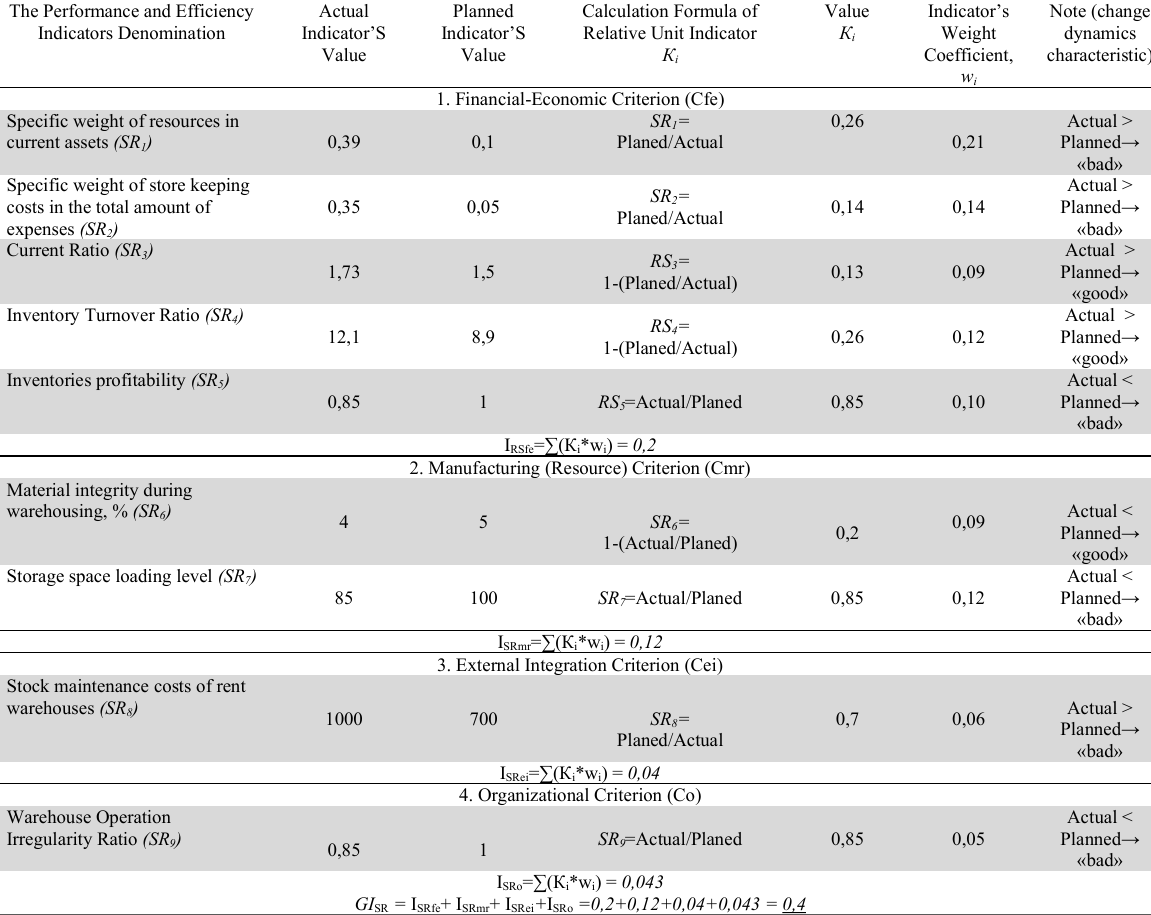
Determination of performance and efficiency indicators of material and technical resources storage business processes execution of a building production (SR)